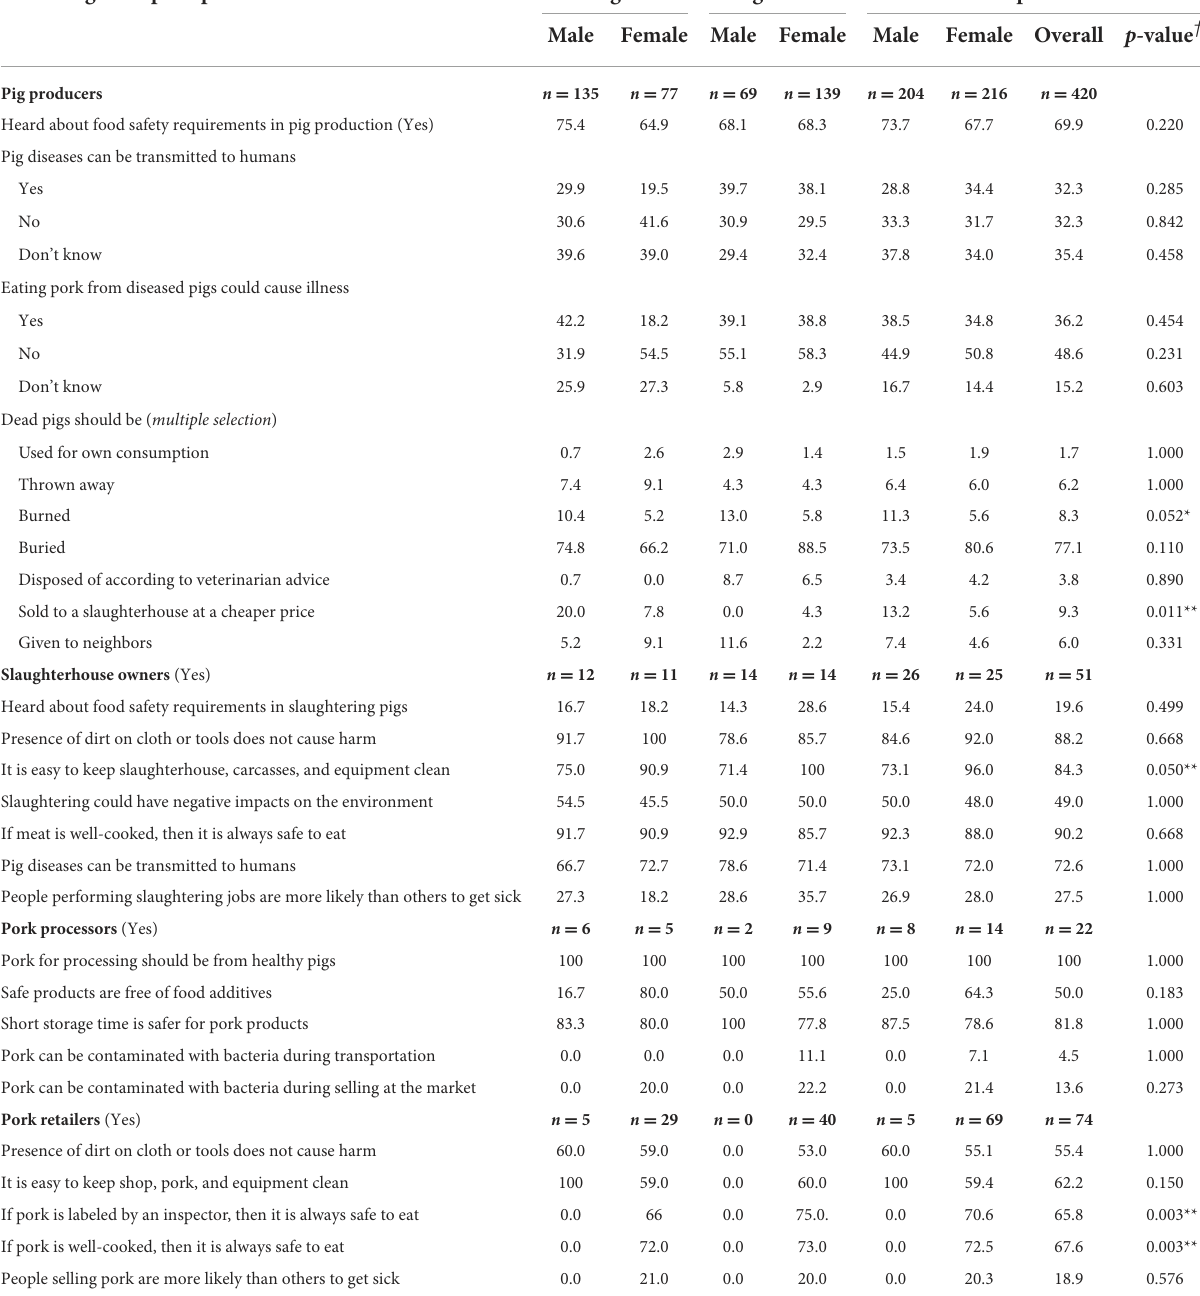
TABLE 3 Knowledge and perceptions of value chain actors on food safety and zoonotic diseases, by gender (%). Knowledge and perceptions Hung Yen Nghe An Both provinces Male Female Male Female